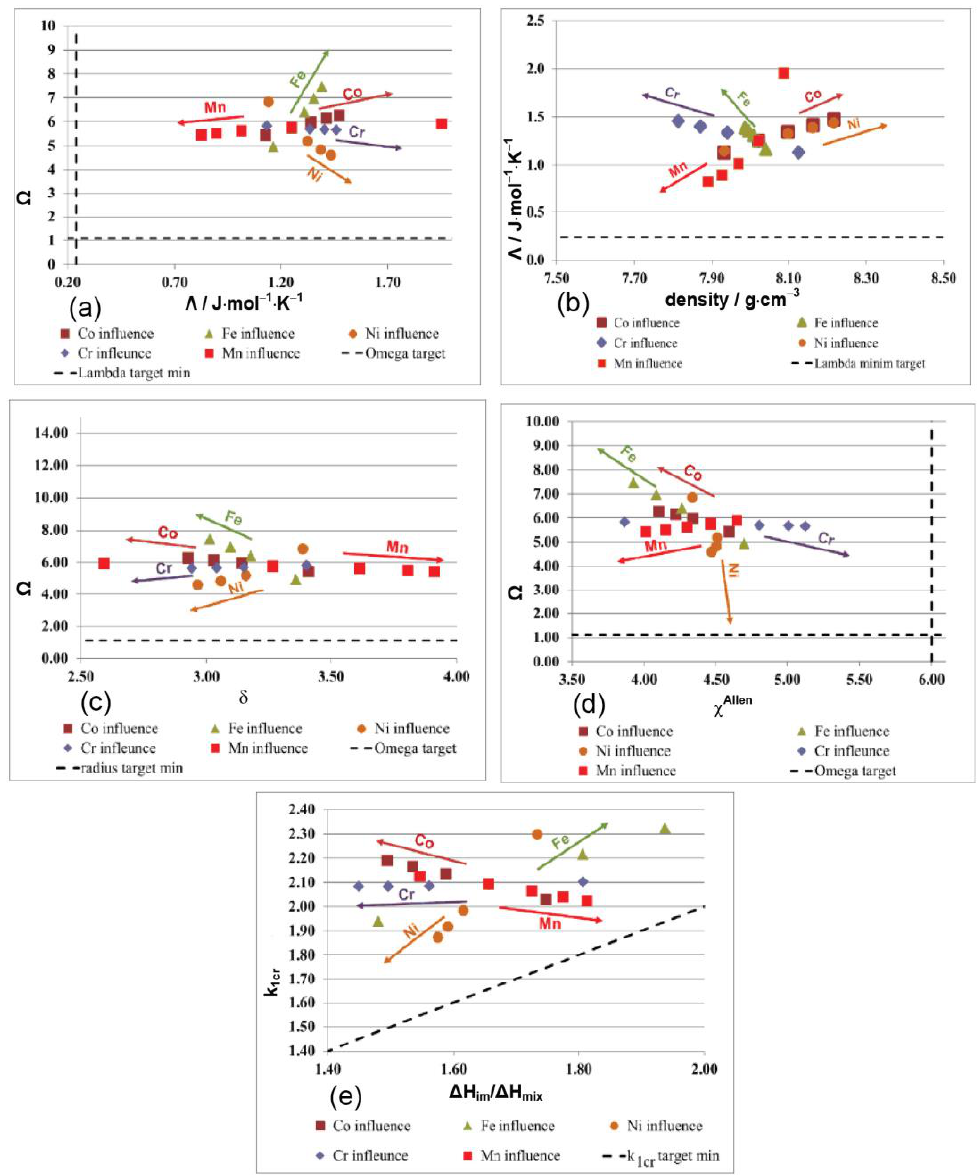
Figure 2. The influence of the constituent concentration on the ratio: ( a ) Ω vs. Λ; ( b ) Λ vs . ρ; ( c ) Ω vs. δ ; ( d ) Ω vs . χ Allen ; and ( e ) k1cr vs . Δ H im /Δ H mix , for the CoCrFeMnNi alloy.